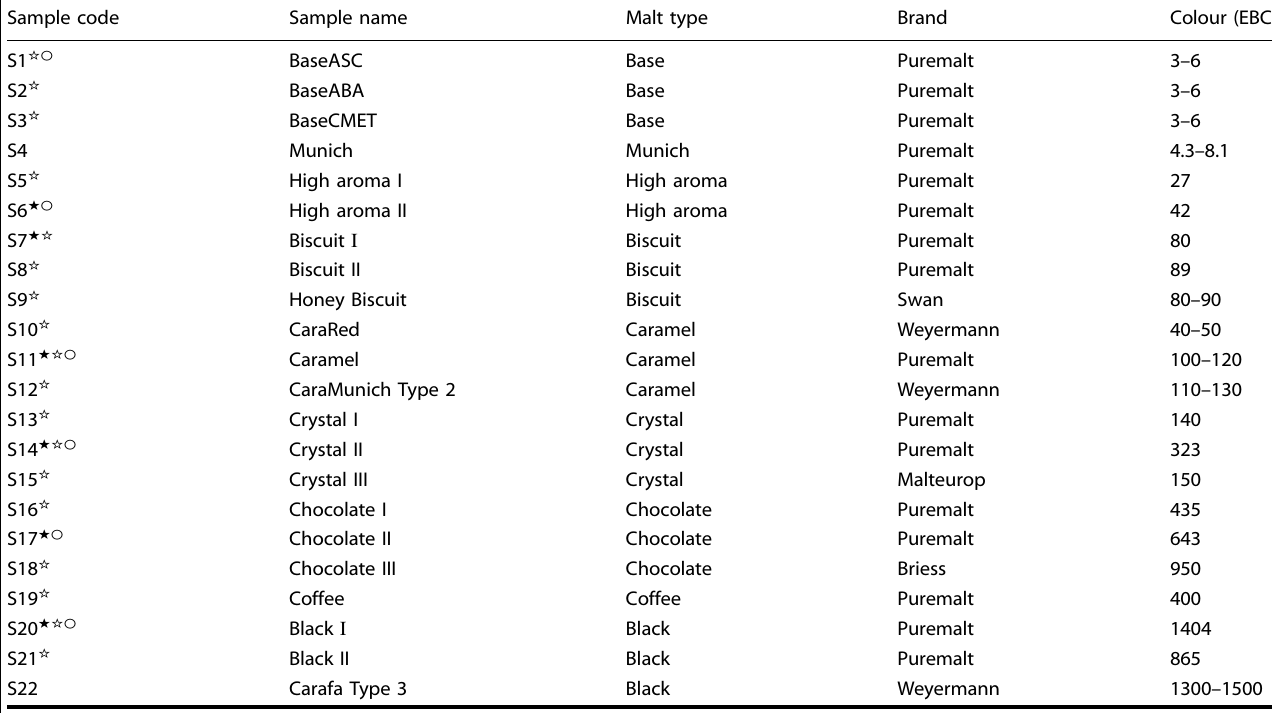
Table 3. Overview of the brewing malt samples. Sample code